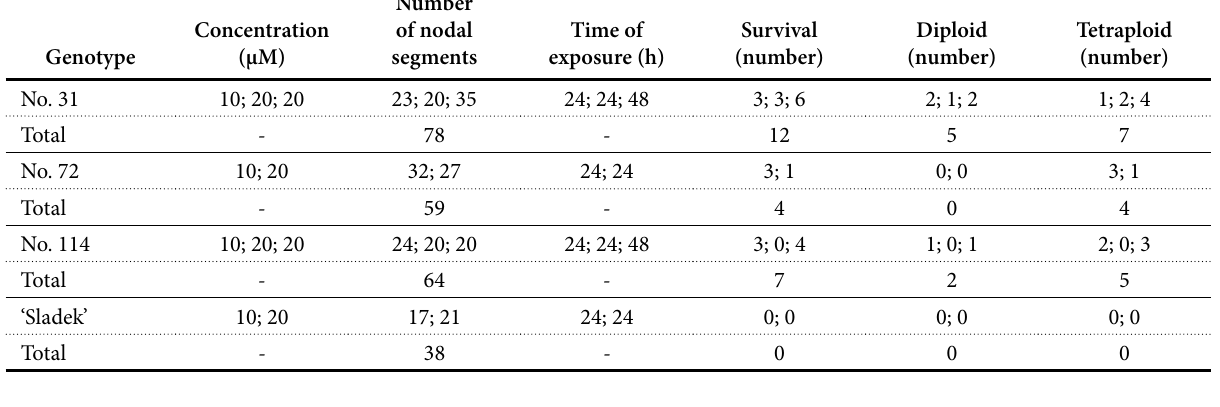
Tab. 2 Irrigation of nodal segments of Osvald’s clones and ‘Sladek’ cultivar with oryzalin solution for 24/48 h.